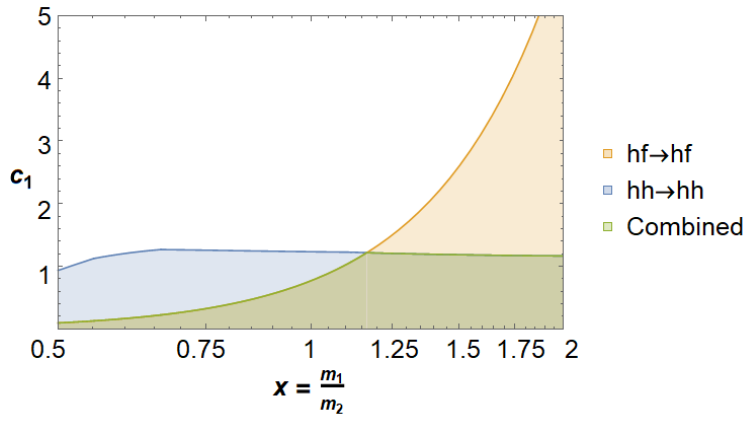
Figure 8 . The allowed values of the cubic coupling, c 1 , as a function of the mass ratio, x , for c 2 = 0 and (cid:13) = 1. The maximum values of c 1 (solid lines) correspond to the c 1 values at which the allowed island in the ( (cid:20) 3 ; (cid:20) 4 ) plane shrinks to a point (blue) or the bounds from hf ! hf scattering cannot be satis(cid:12)ed (orange). The combined maximum value of c 1 is c one cubic x = 1 :